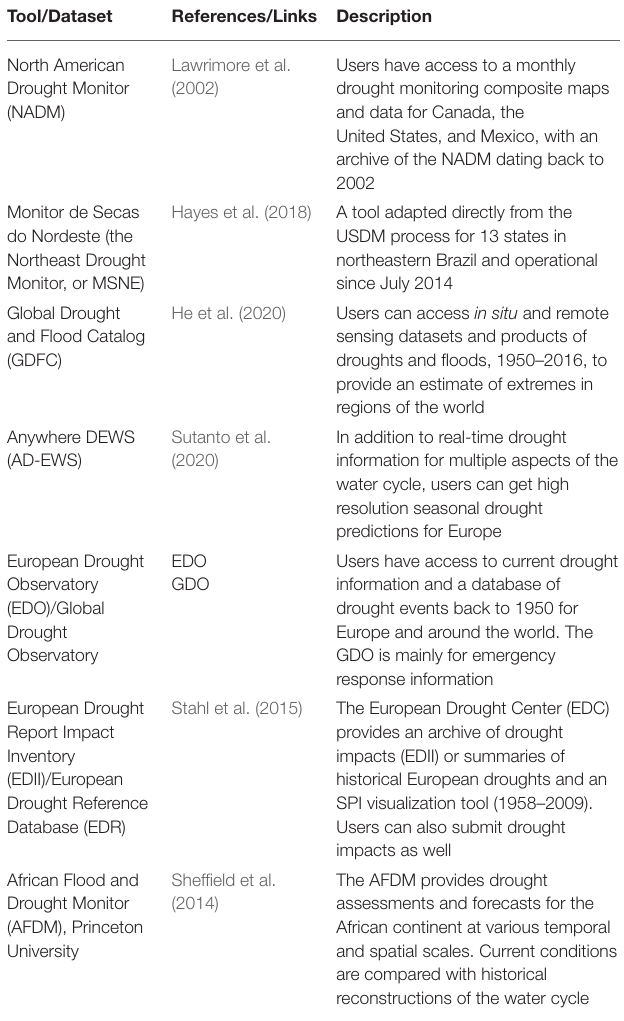
TABLE 2 | International drought monitoring activities.